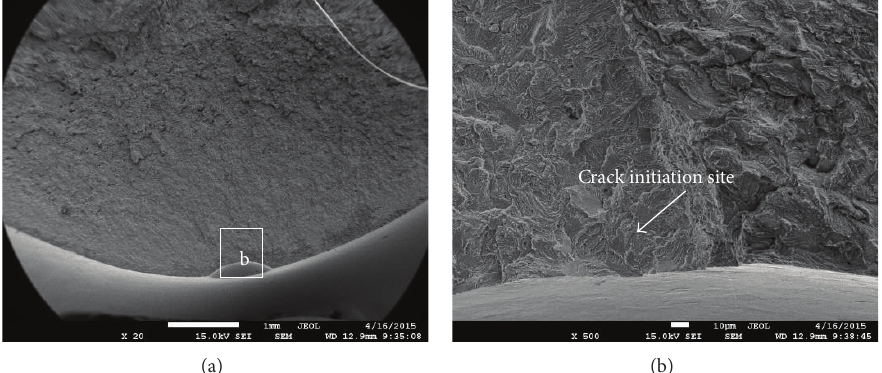
mechanical polishing, the mechanical property and stress condition of the top layer may well be altered by